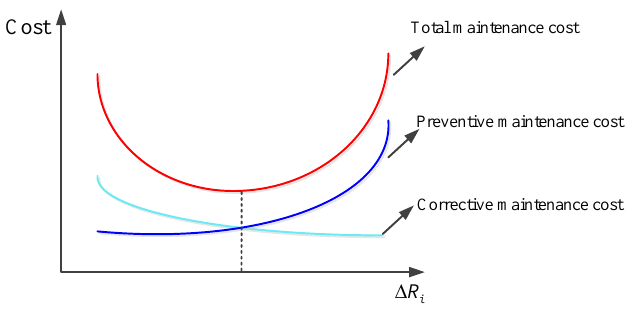
Figure 6. System maintenance cost curve.